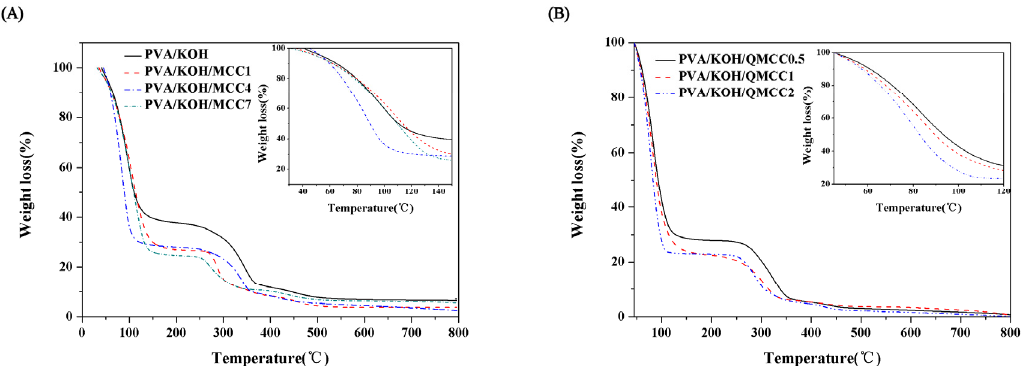
Figure 5. ( A ) TGA curves of PVA/KOH alkaline electrolyte membranes with various contents of MCC. ( B ) TGA curves of PVA/KOH/QMCC alkaline electrolyte membranes.